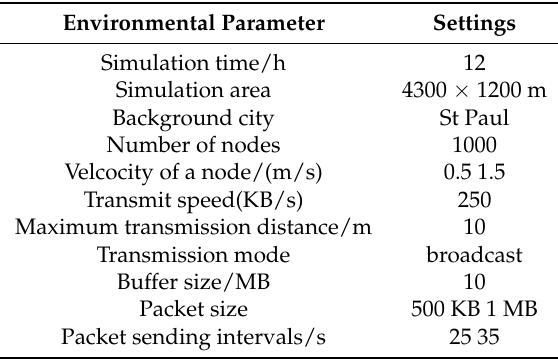
Table 1. Environmental parameter of simulation settings.